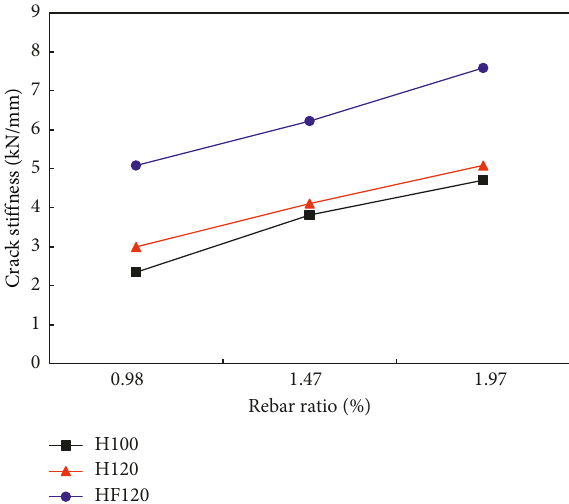
Figure 10: Crack stiffness of the HSFRC and HSC beams.